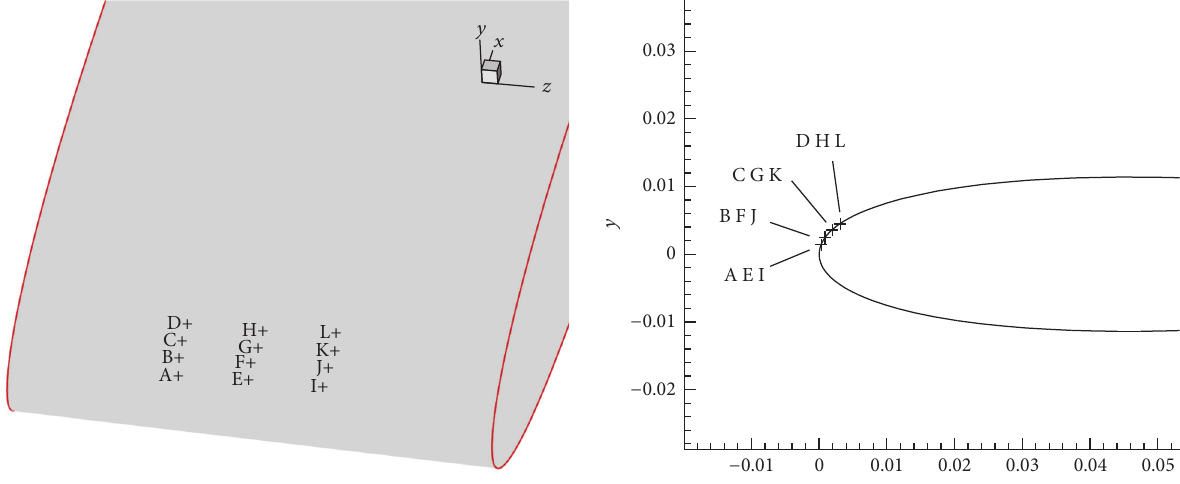
Figure 7: Coordinates and point